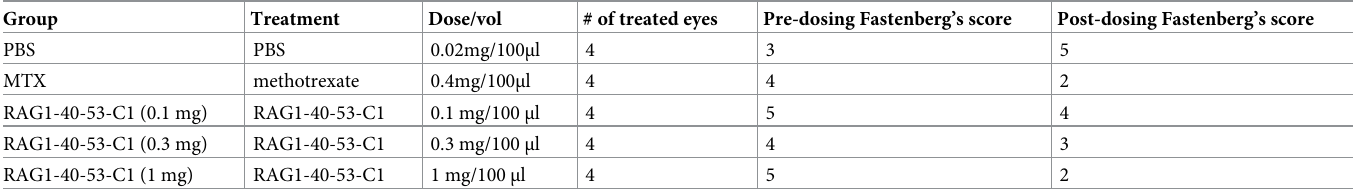
Table 2. Treatment groups and outcome assessed by Fastenberg’s